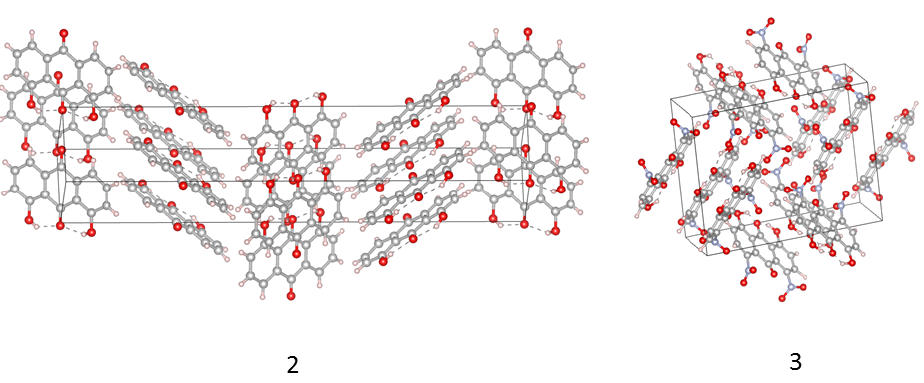
Figure 2. The crystallographic unit cells with the molecules arrangement for the compounds 2 and 3 [21,22]. The dotted lines indicate the presence of intramolecular hydrogen bonds. The data was used for CPMD simulations in the crystalline